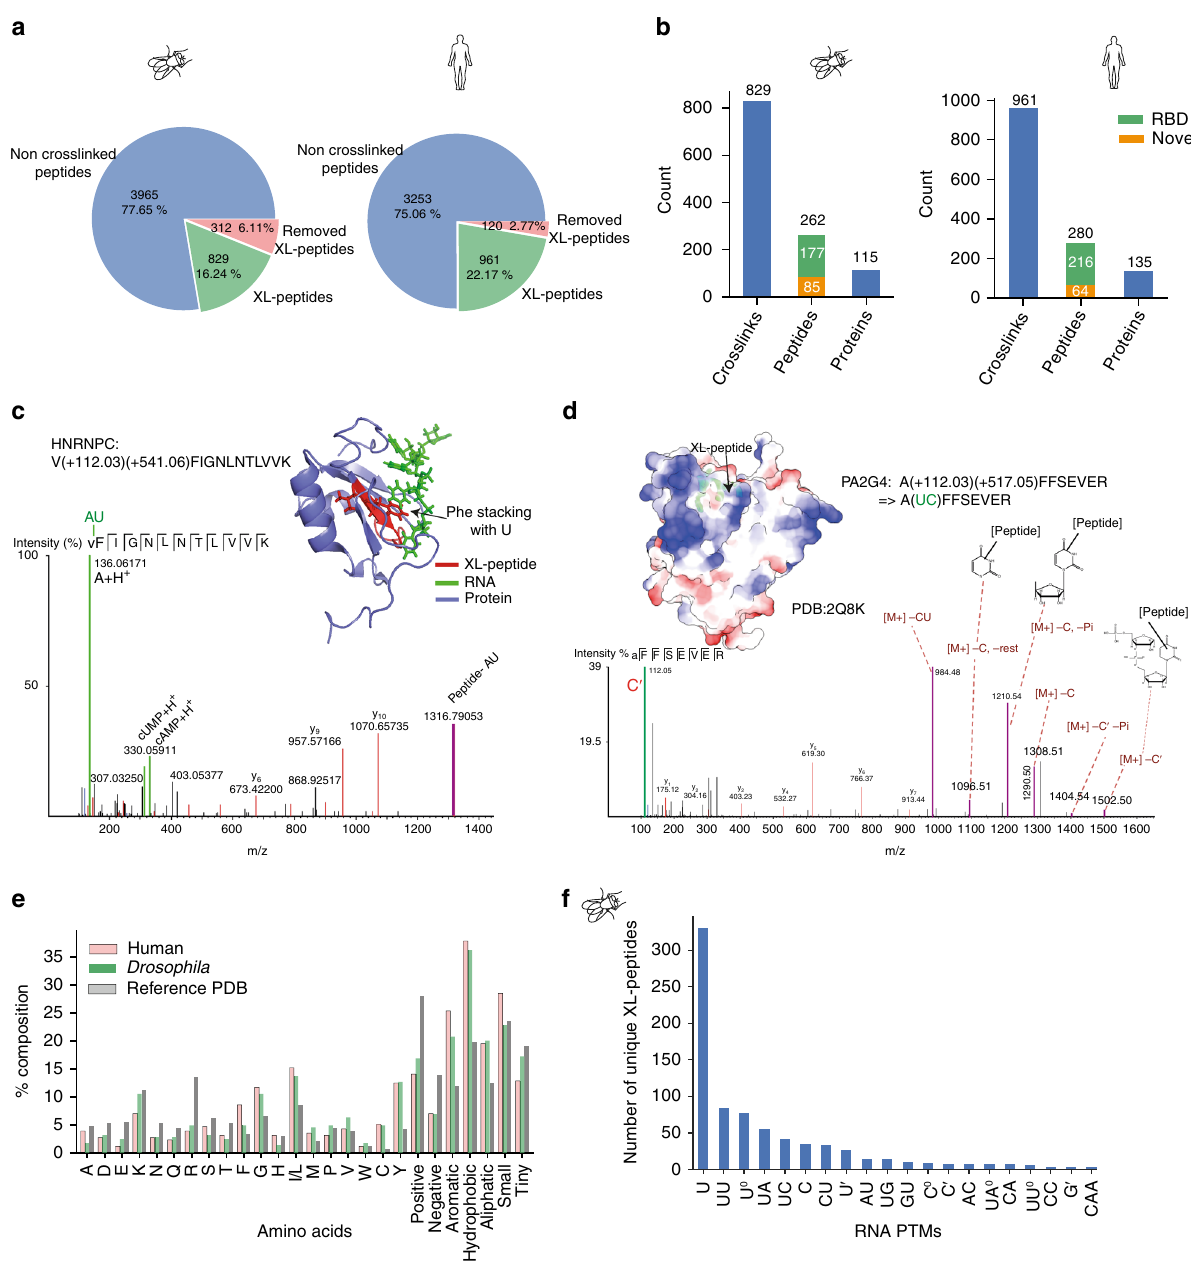
Fig. 4 Identi fi cation of UV crosslinked XL-peptides using PEAKS PTM analysis. a Peptides detected in Drosophila (left) and human (right) PEAKS analysis: canonical non-crosslinked peptides (blue), fi ltered crosslinked peptides (red) and true XL-peptides (green). b Summary of all XL-peptides detected in Drosophila (left) and human (right). The crosslinks bar depicts the number of distinct RNA-peptide heteroconjugates. The peptides bar depicts the number of distinct peptide sequences. The proteins bar depicts the number of distinct proteins that are de fi ned by the aforementioned peptides. c An example of an annotated XL-peptide spectrum from HNRNPC with a dinucleotide (AU) covalently attached to peptide VFIGNLNTLVVK. The y ions series (blue) and b ion series (red) were automatically annotated by PEAKS. The manually added RNA marker ions (A + , cUMP + , cAMP + ) and RNA-peptide conjugates (peptide-AU) are shown in green and in magenta, respectively. Inset: The XL-peptide mapped to amino acids 18 – 28 in HNRNPC structure (PDB ID 2MXY). The protein is shown in blue, the RNA in green and the XL-peptide in red. Amino acids Phe and Val are shown in ball and stick models. The stacking interaction between Phe and proximal uridine base is pointed out (arrowhead). d Annotated spectrum of an XL-peptide peptide from PA2G4. The m / z ratios identi fi ed by PEAKS search are shown in red. The marker ion (C ’ ) is shown in green. The peaks containing heteroconjugates with neutral losses are shown in purple. The nucleotide structures are shown for the purpose of visualising adducts present on the peptides and they may not represent the actual structure of the heteroconjugate. Inset: Position of the XL-peptide (green) in the crystal structure of the protein (PDB ID 2Q8K). The coulombic electrostatic potential of the protein surface is shown in blue for positive and red for negatively charged surfaces. e Composition analysis of amino acids identi fi ed as sites of crosslinks in Drosophila (green) and human (pink) compared to the composition of amino acids involved in direct interaction with RNA in known 3D structures (grey) 38 . f Bar chart displaying the distribution of ribonucleotide adducts observed in Drosophila